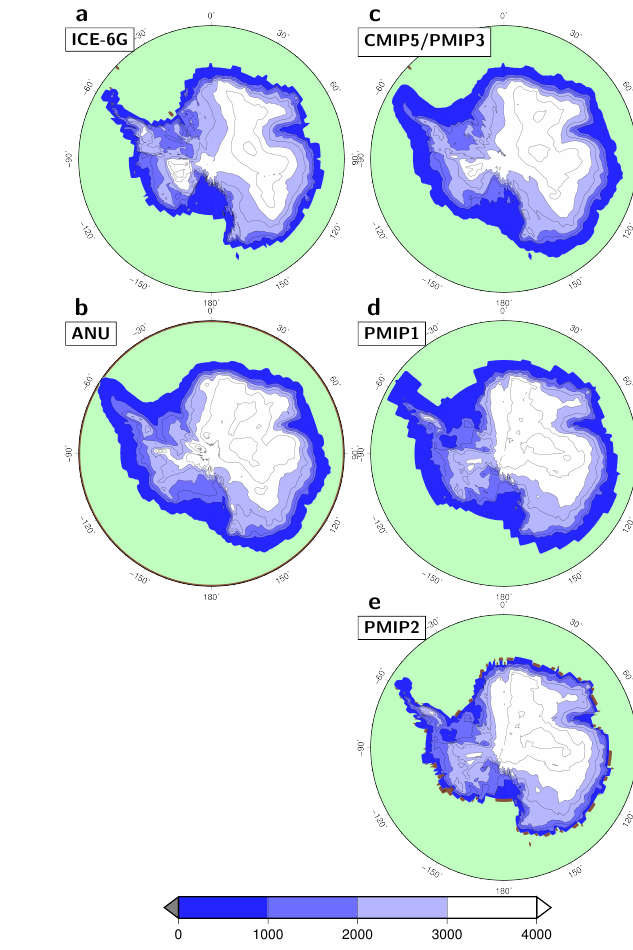
Figure 2. Difference in surface elevation (m) of the Northern Hemi- sphere ice sheets at the LGM compared to the present day from the (a) ICE-6Gv.2, (b) GLAC-1a and (c) ANU reconstructions, and for the (d) CMIP5/PMIP3 composite compared to the ice sheets used in (e) PMIP1 and (f) PMIP2. The region shown is between 40 and 90 ◦ N.